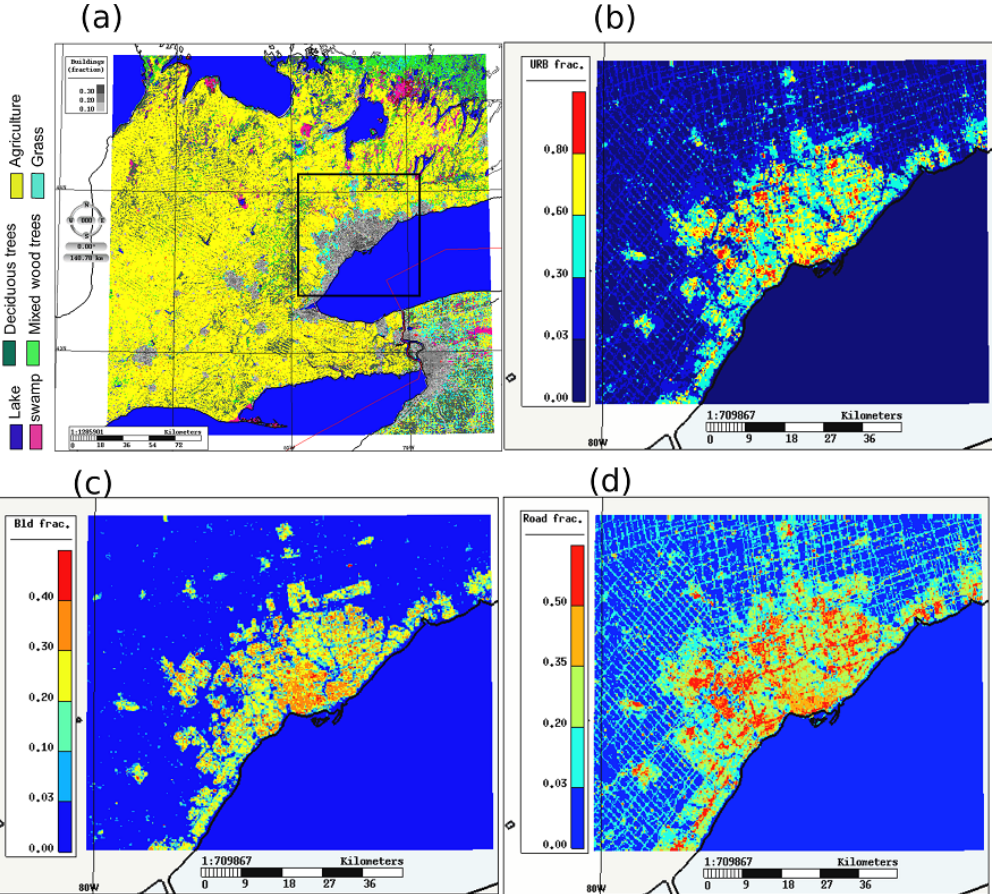
Figure 3. Surface description in TOR-GEM250. Dominant Land Use/Land Cover (LULC) and the limit of the refined region over GTA (black square) ( a ), with hereafter: urban fraction ( b ), building fraction ( c ), and road or pavement fraction ( d ). The Lake Ontario shoreline is in